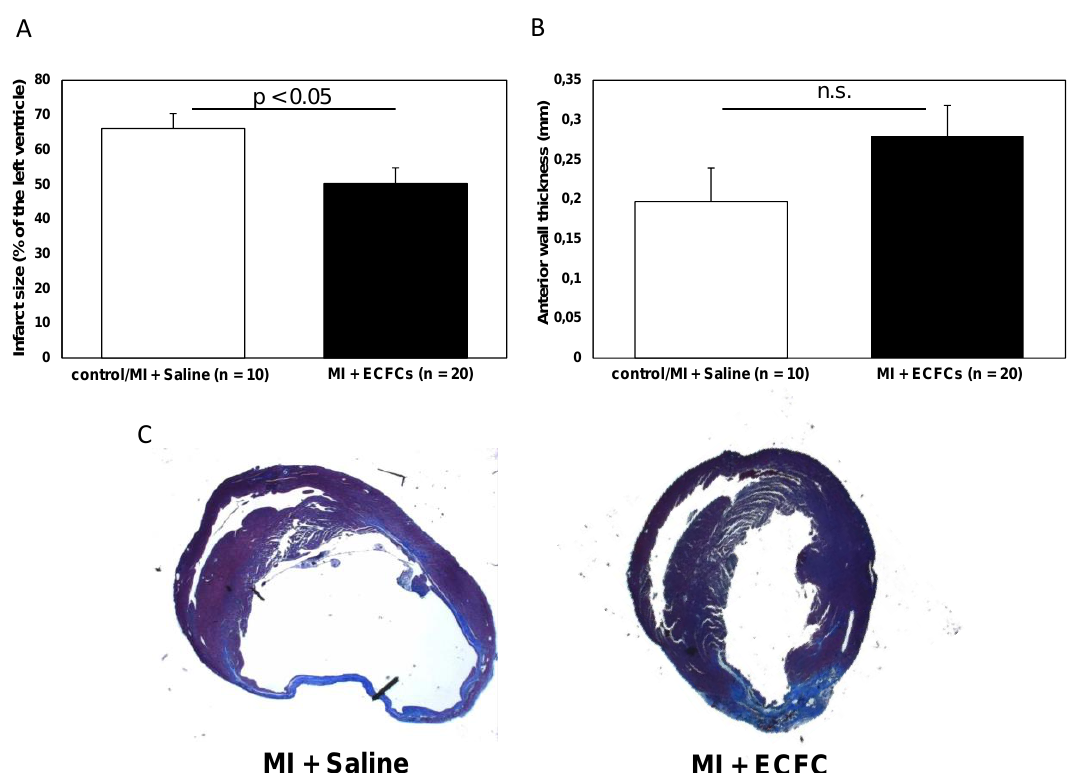
Figure 2. Attenuated infarct remodeling after human ECFC transplantation into ischemic myocardium. ( A ) Bar graphs representing the size of infarction (%) in saline-treated animals (white bar) and ECFC-treated animals (black bar) 30 days after MI. ( B ) Bar graphs representing anterior wall thickness (mm) in saline-treated animals (white bar) and ECFC-treated animals (black bar) 30 days after MI. Data represent mean ± SEM; n.s., not significant. ( C ) Representative Masson trichrome staining of infarcted hearts 30 days after MI.